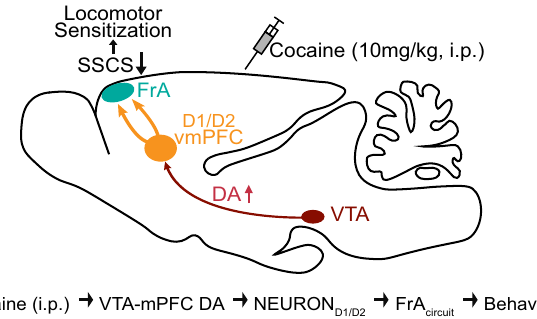
Fig. 7 | Cartoon illustration that cocaine induces hypoactivity of the FrA and locomotor sensitization through the dopamine-dependent vmPFC – FrA path- way. The working model is that acute cocaine exposure (10mg/kg, i.p.) decreases FrA neuronal activity (SSCS), which is critical for cocaine-induced locomotor sen- sitization, through a dopaminergic VTA – vmPFC pathway relayed by a vmPFC – FrA cortico-cortical projection: Cocaine (i.p.) → VTA-mPFC DA transmission → mPFC NEURON D1/D2 → FrA circuit →